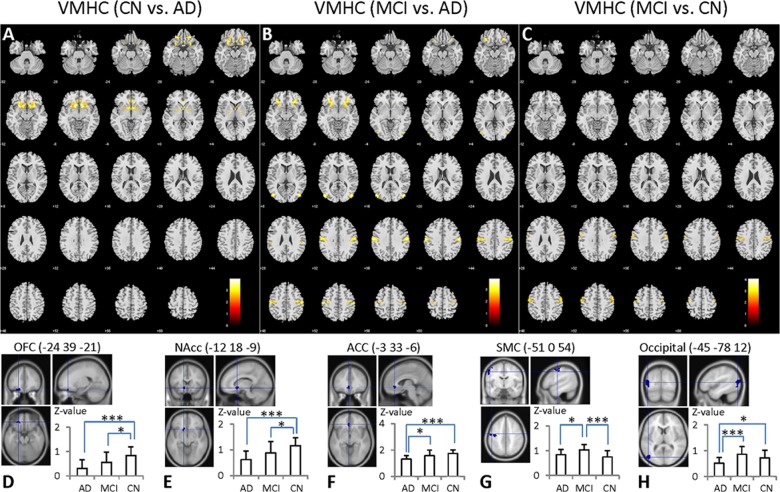
Cross-cohort comparisons of VMHC.
A: The AD subjects showed significantly decreased VMHC in the OFC, ACC, POC, NAcc, putamen, caudate and insula compared to CN. B: The AD subjects showed significantly decreased VMHC in the OFC, putamen, caudate, insula, SMC, and OcG compared to MCI. C: The MCI subjects showed significantly increased VMHC in the SMC compared to CN. D-H show the locations of the five anatomical structures where the VMHC was significantly different across the three cohorts. The values in the bar graphs are z-scores transformed from the VMHC values. * represents statistical differences between groups (*, p ≤ 0.05; ***, p ≤ 0.001).